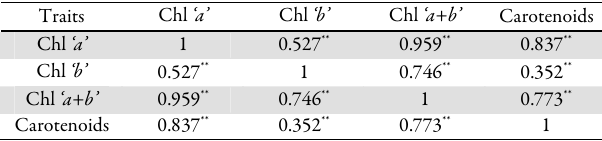
Tab. 3. Pearson’s correlation among the investigated parameters Traits